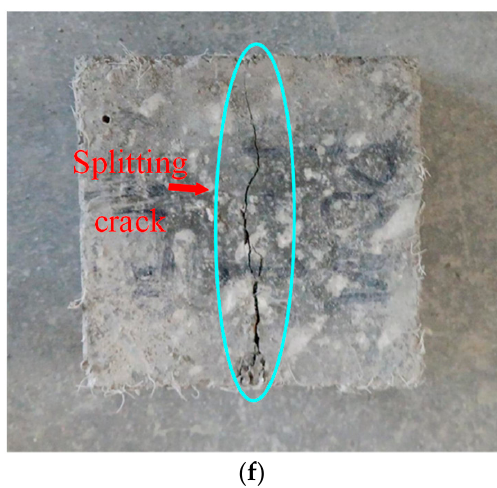
Figure 20. Failure performance of splitting tensile tests: ( a ) NF; ( b ) POM-0.2; ( c ) POM-0.4; ( d ) POM-0.6; ( e ) POM-0.8; ( f ) POM-1.